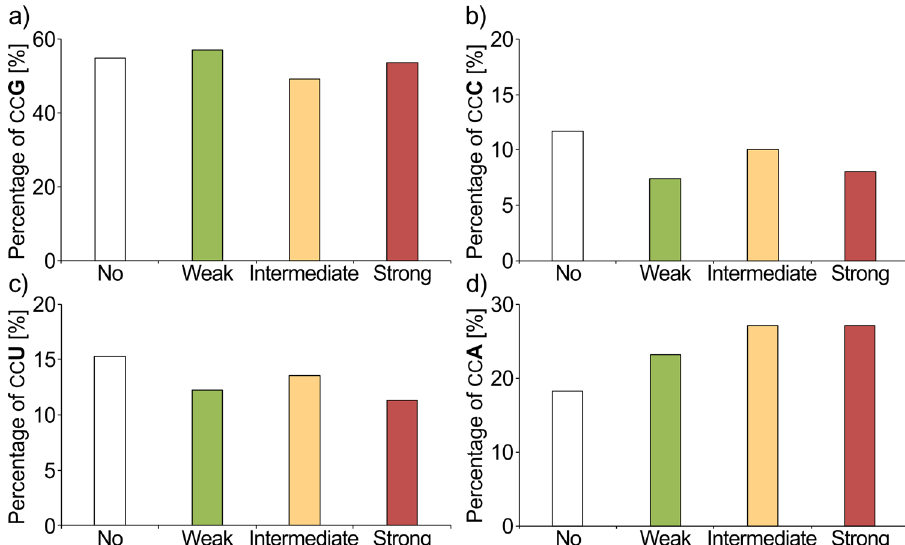
Fig. 3 Codon usage in PP-motifs of different pausing strength. Pausing strength of PP-motifs depends on the upstream amino acid context 11,20,22 resulting in weak, intermediate, and strong pausers. The pausing strength resulting from amino acid context is indicated by colored bars (no pausing — white; weak pausing — green; intermediate pausing — yellow; strong pausing — red). Codon usage in differently strong pausing motifs is shown for CCG ( a ),